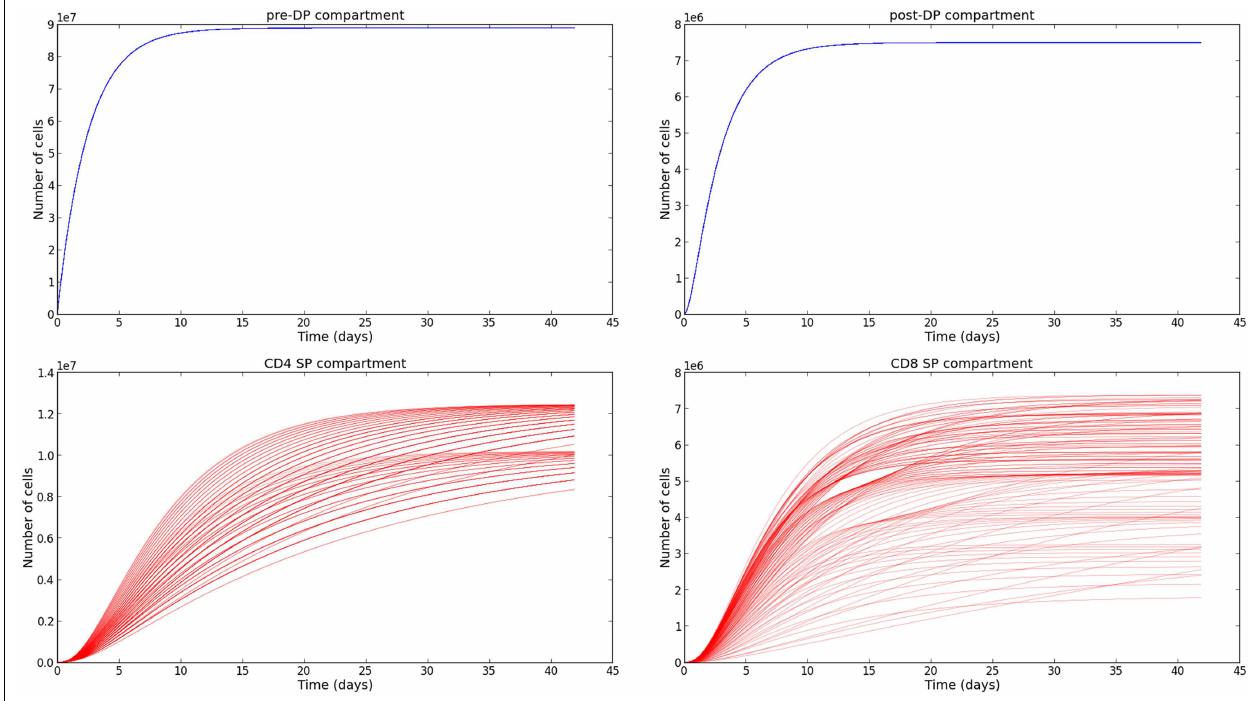
Frontiers in Immunology |T Cell